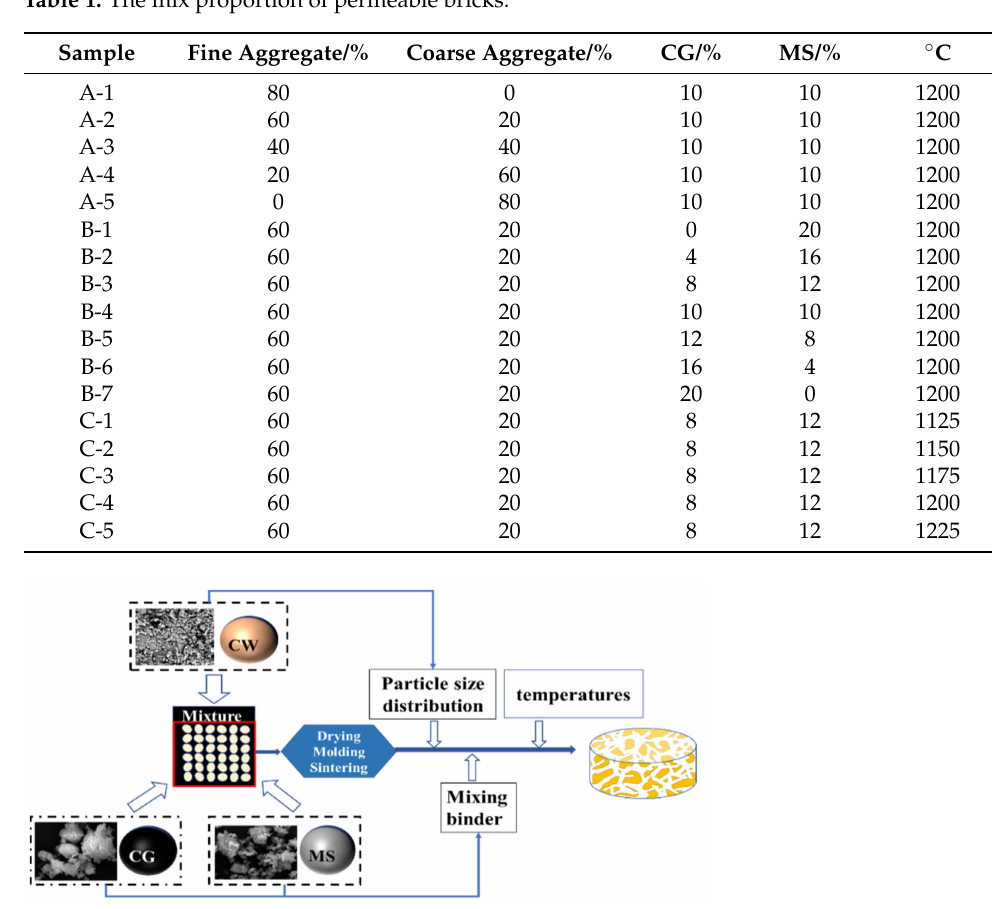
Figure 1. The preparation process of permeable